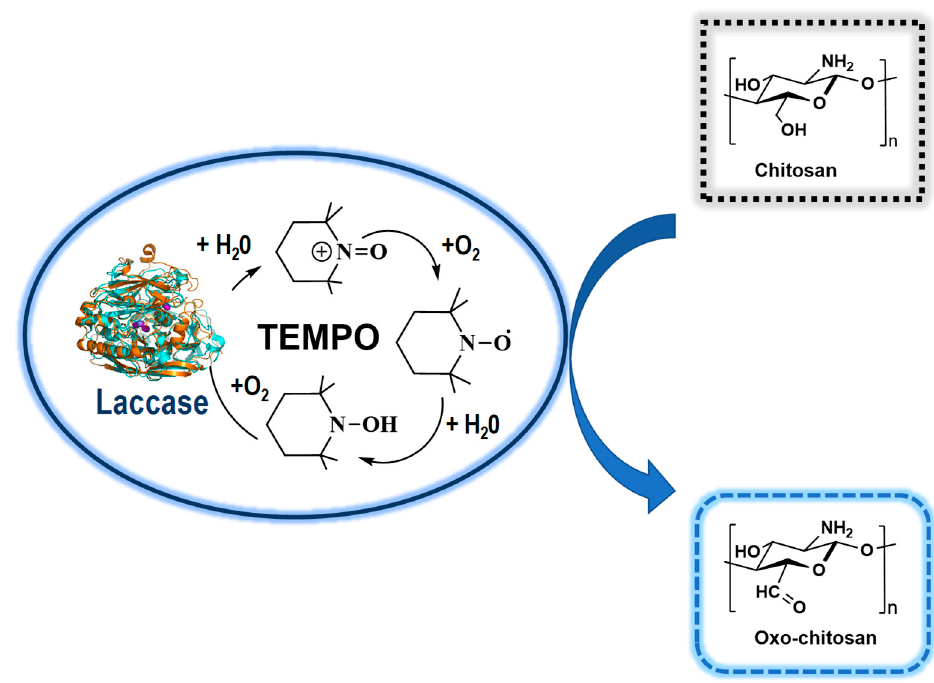
Figure 4. Environmentally friendly oxidation of CS via TEMPO/laccase system (adapted from [52]).